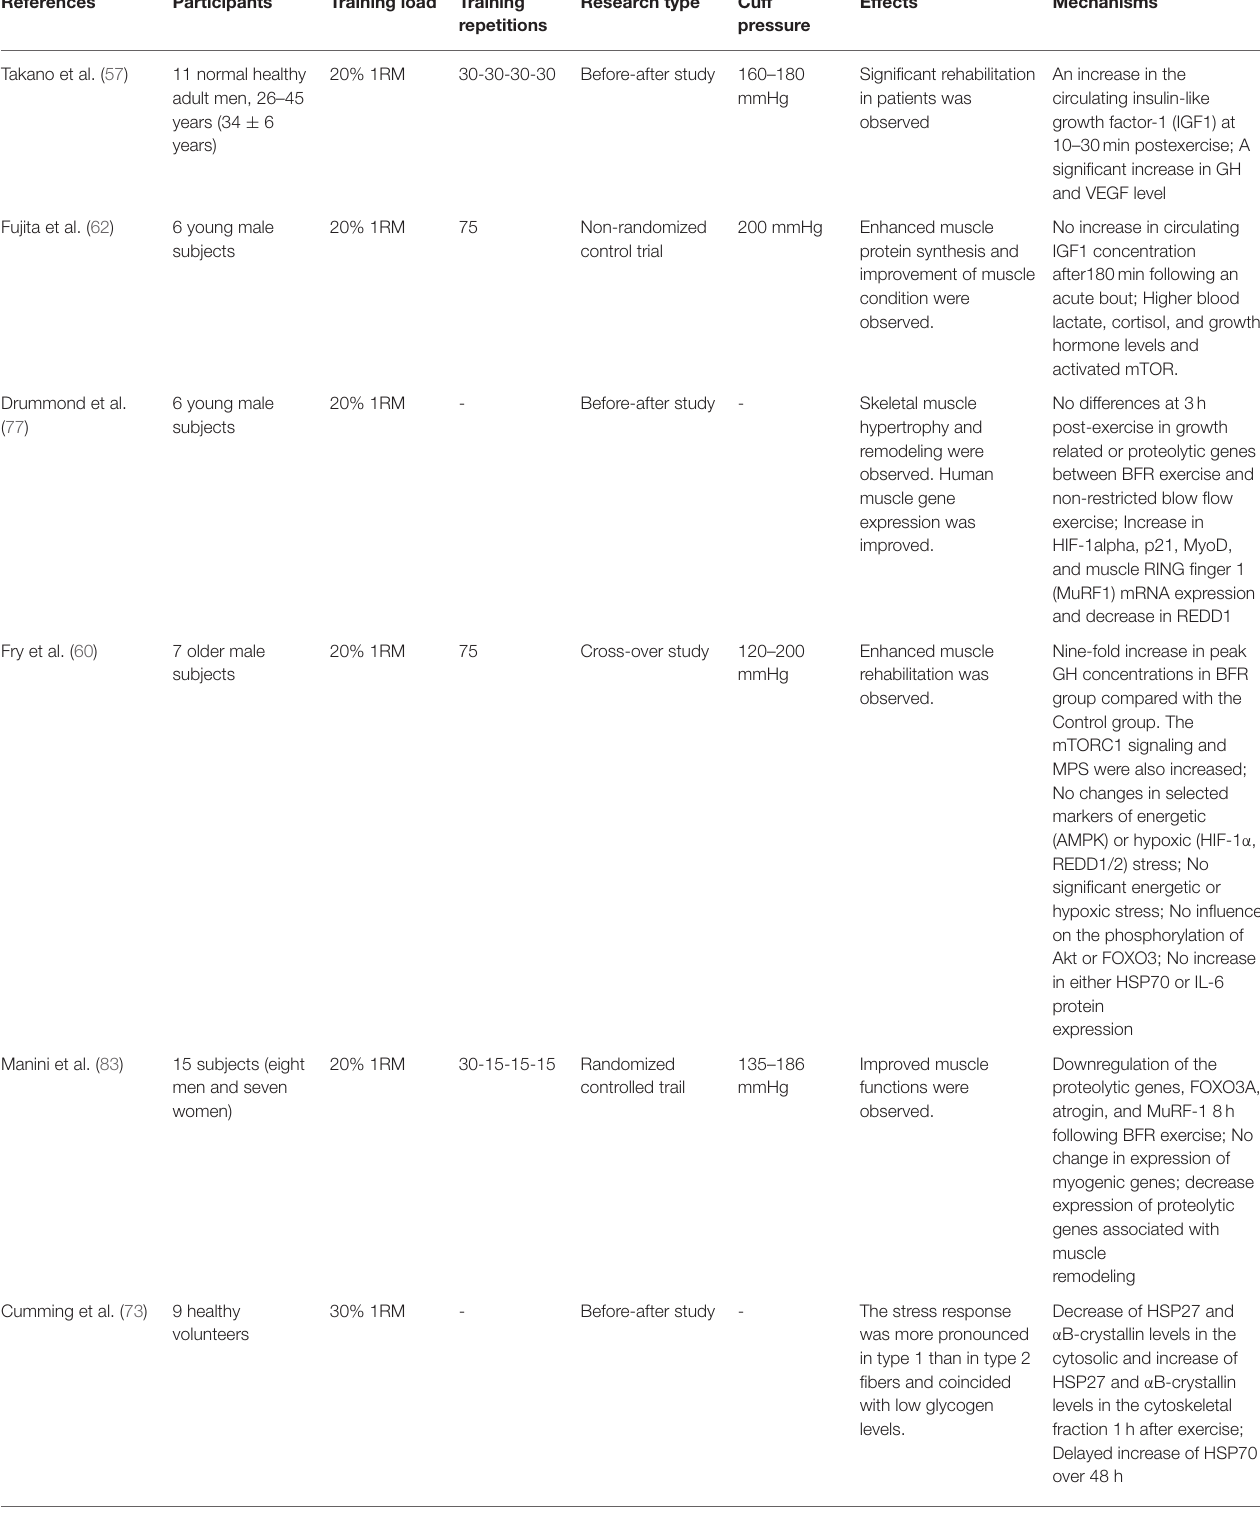
TABLE 2 | The management of sarcopenia through BFRT and its research